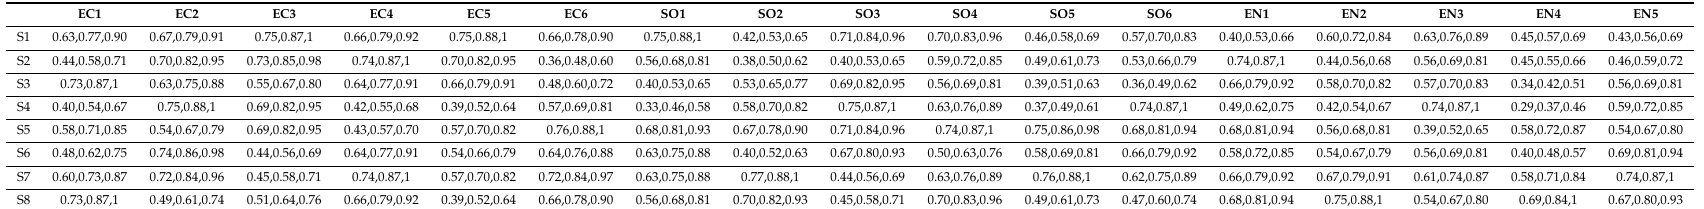
Table A11. Fuzzy normalized decision matrix.